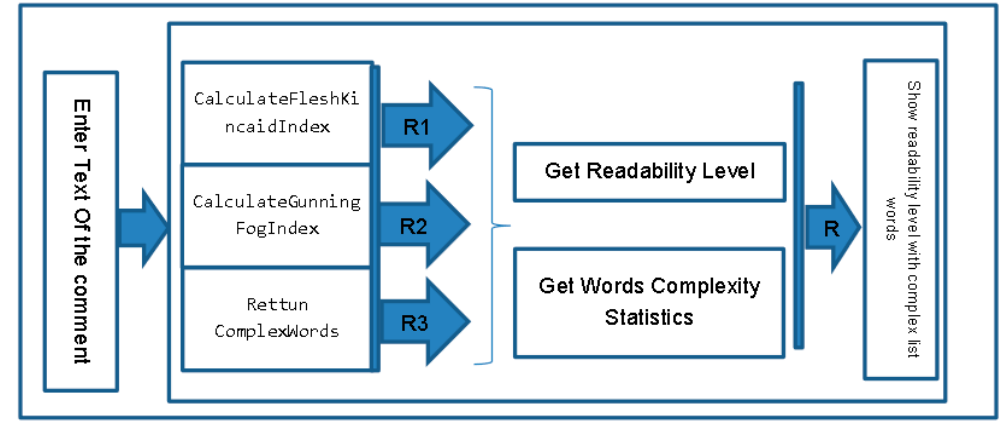
Figure 4. Module functions and processes.